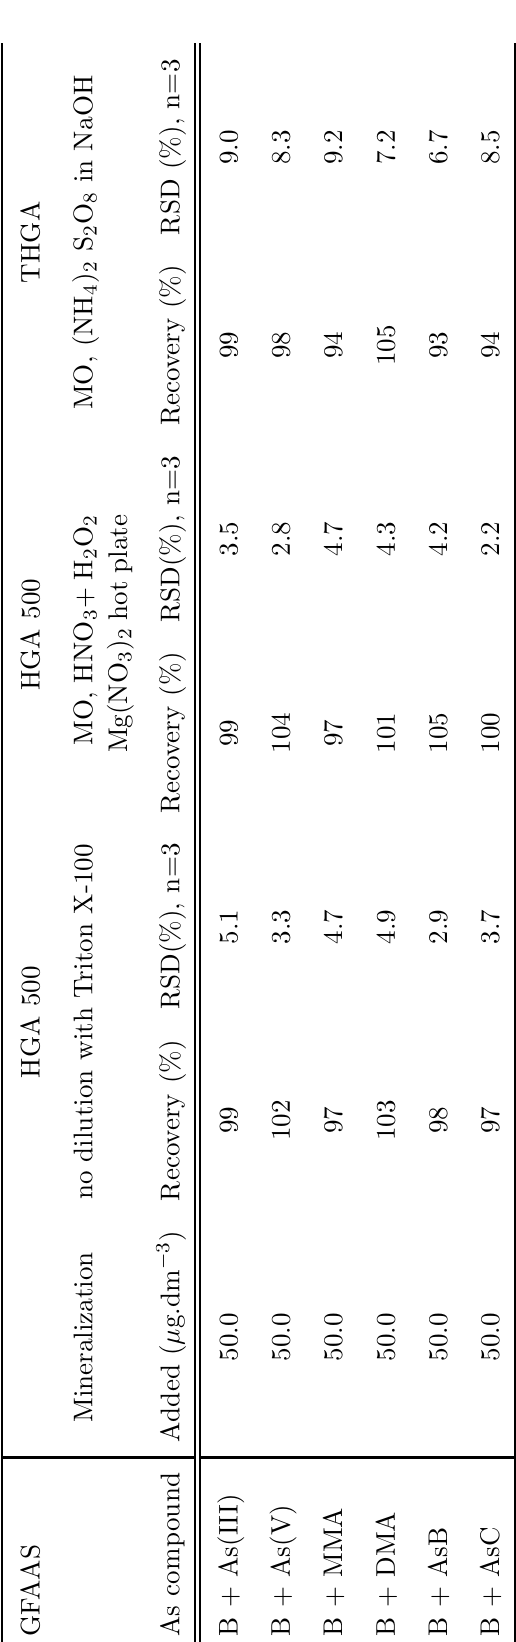
Table 3 Recovery of As in blood by GFAAS without and after di¬erent mineralization proce- dures. Control sample B (Seronorm